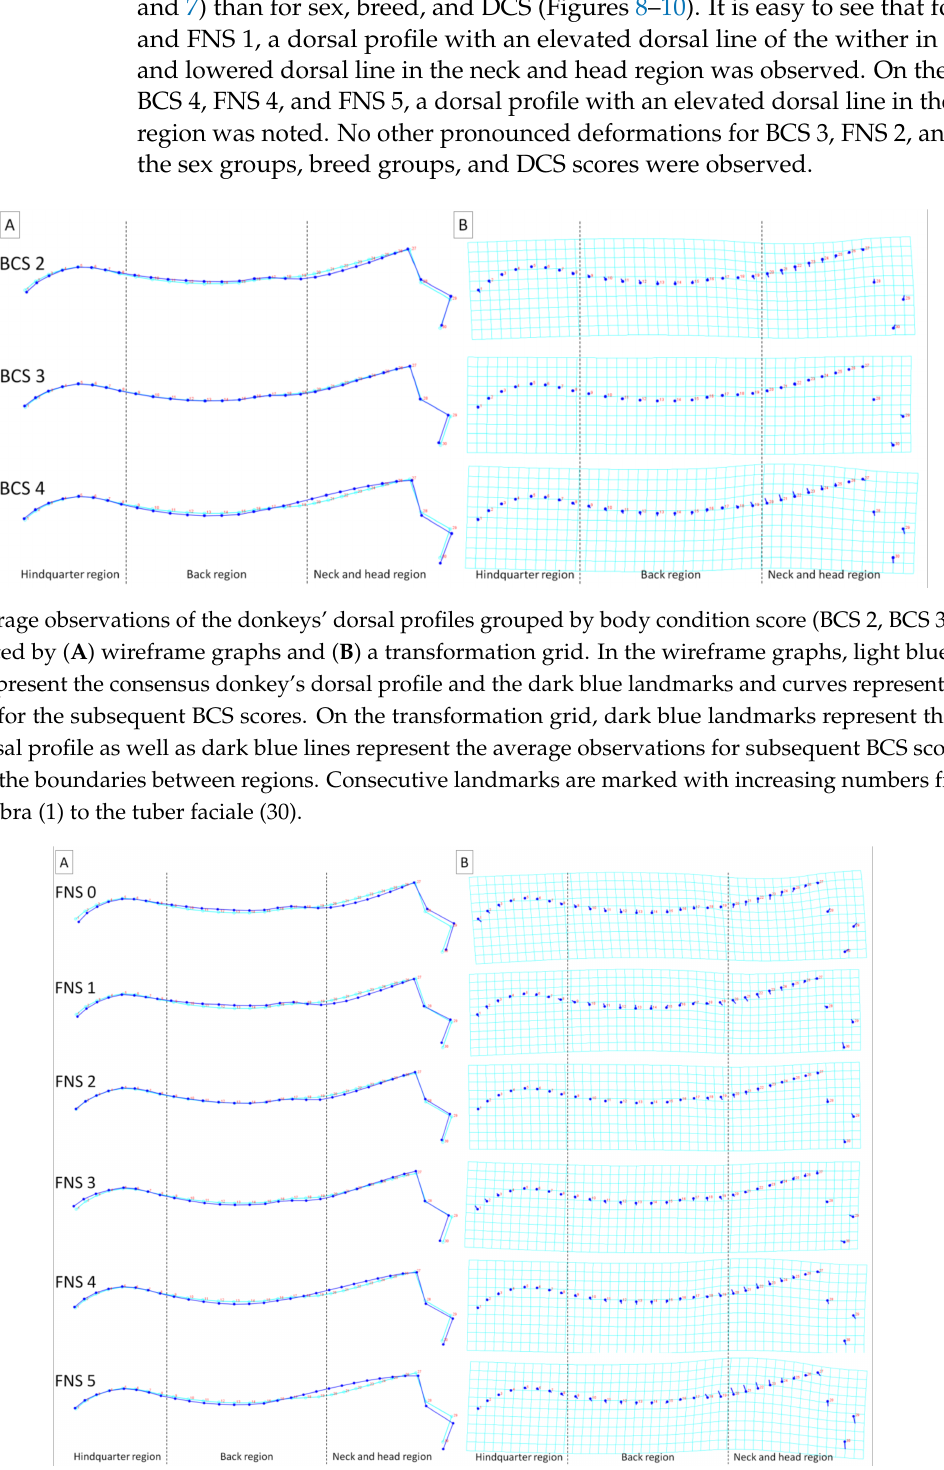
Figure 7. Average observations of the donkeys’ dorsal profiles grouped by fatty neck score (FNS 0, FNS 1, FNS 2, FNS 3, FNS 4, and FNS 5) and represented by ( A ) wireframe graphs and ( B ) a transformation grid. In the wireframe graphs, light blue landmarks and curves represent the consensus donkey’s dorsal profile and the dark blue landmarks and curves represent the average observations for the subsequent FNS scores. On the transformation grid, dark blue landmarks represent the consensus donkey’s dorsal profile and the dark blue lines represent the average observations for the subsequent FNS scores. Dashed lines indicate the boundaries between regions. Consecutive landmarks are marked with increasing numbers from the first caudalis vertebra (1) to the tuber faciale